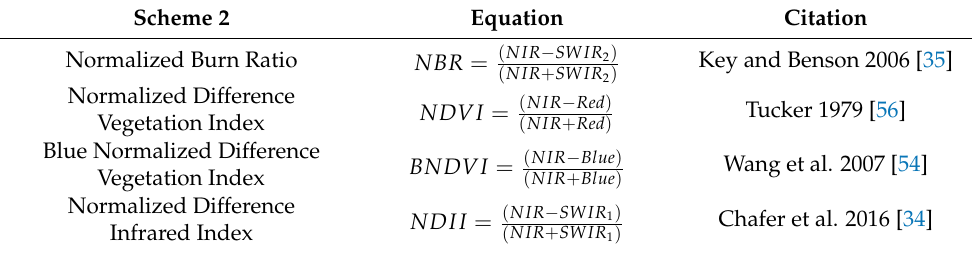
Table 2. Spectral indices used to evaluate ash. Band specifications: blue is p480 nm (L8 band 2, S2 band 2; WV2 band 2); red is p660 nm (L8 band 4, S2 band 4; WV2 band 5); NIR is p860 nm (L8 band 5, S2 band 8a; WV2 band 7); SWIR 1 is p1610 nm (L8 band 6 and S2 band 11); and SWIR 2 is p2200